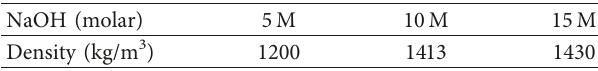
Table 4: Density of NaOH solution with different